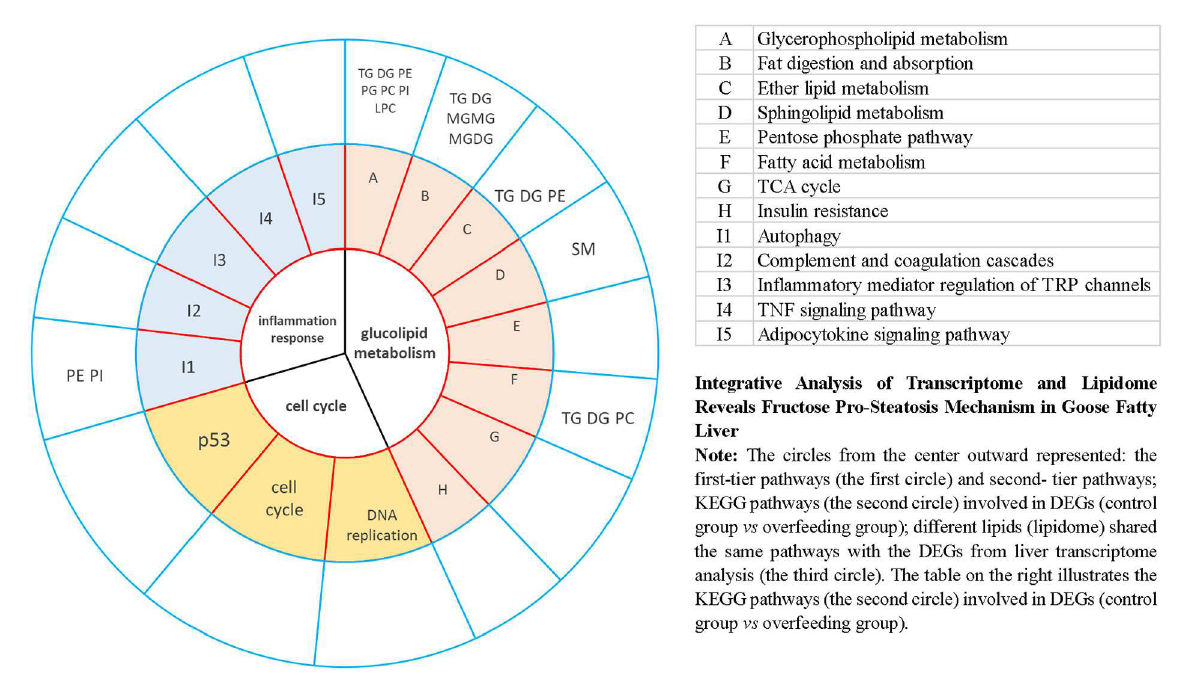
FIGURE6 Integrative analysis of transcriptome and lipidome provides insight into goose fatty liver formation via KEGG